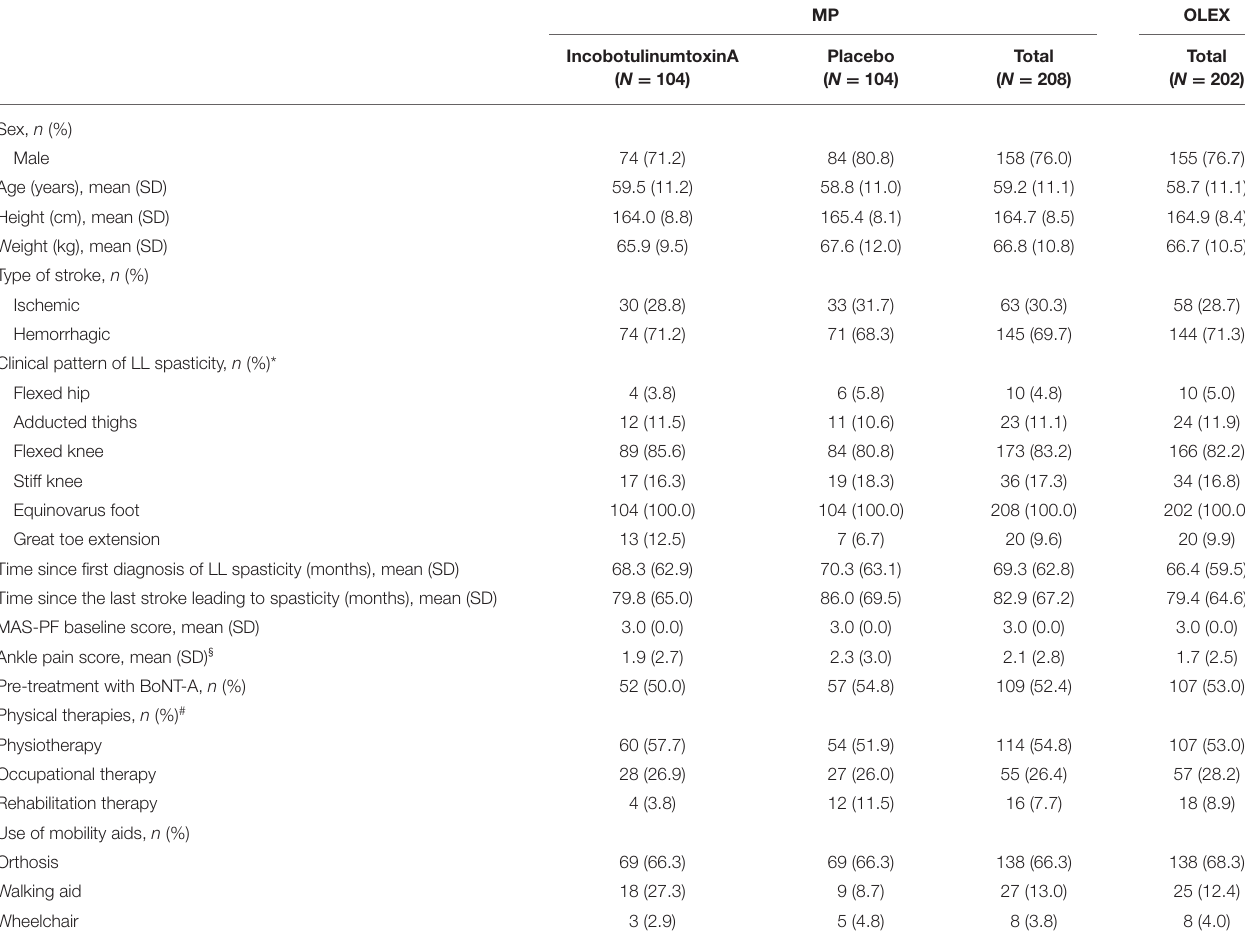
TABLE 1 | Subject demographics and clinical characteristics